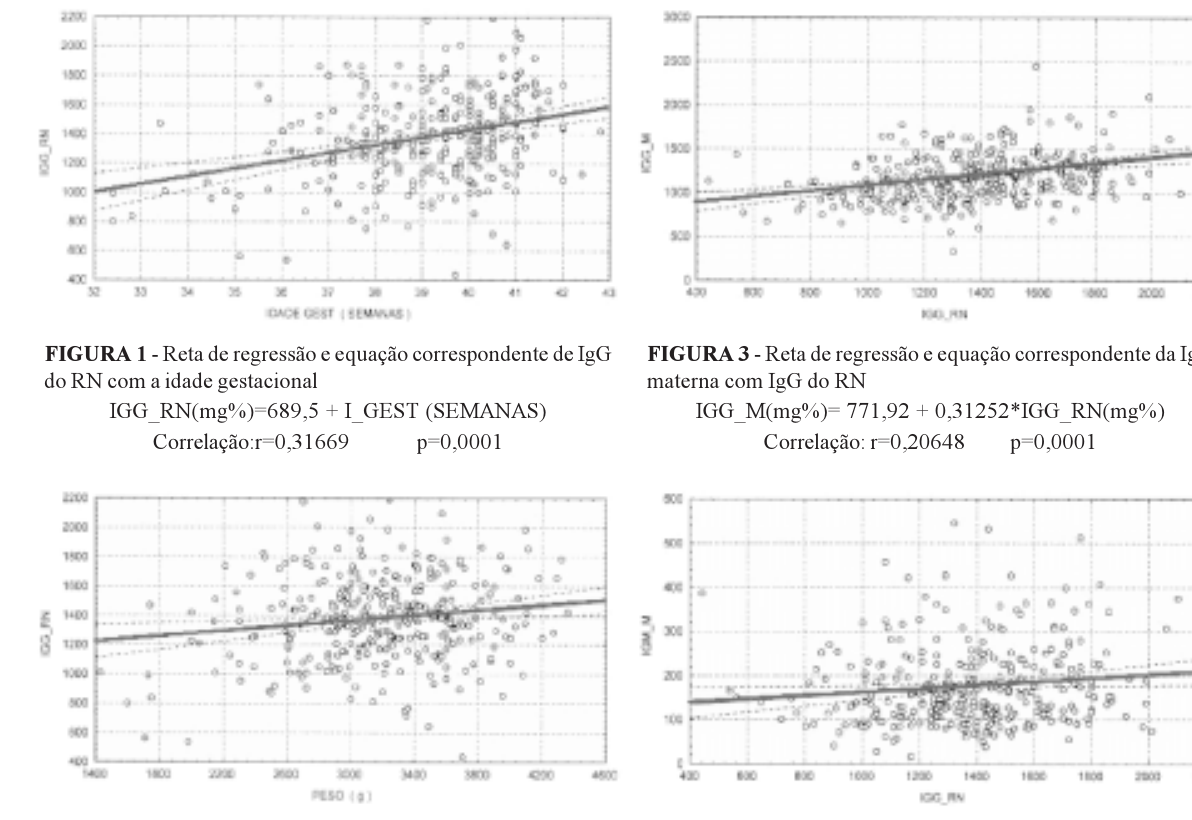
FIGURA 2 - Reta de regressªo e equa(cid:231)ªo correspondente da rela(cid:231)ªo IgG do RN e peso de nascimento